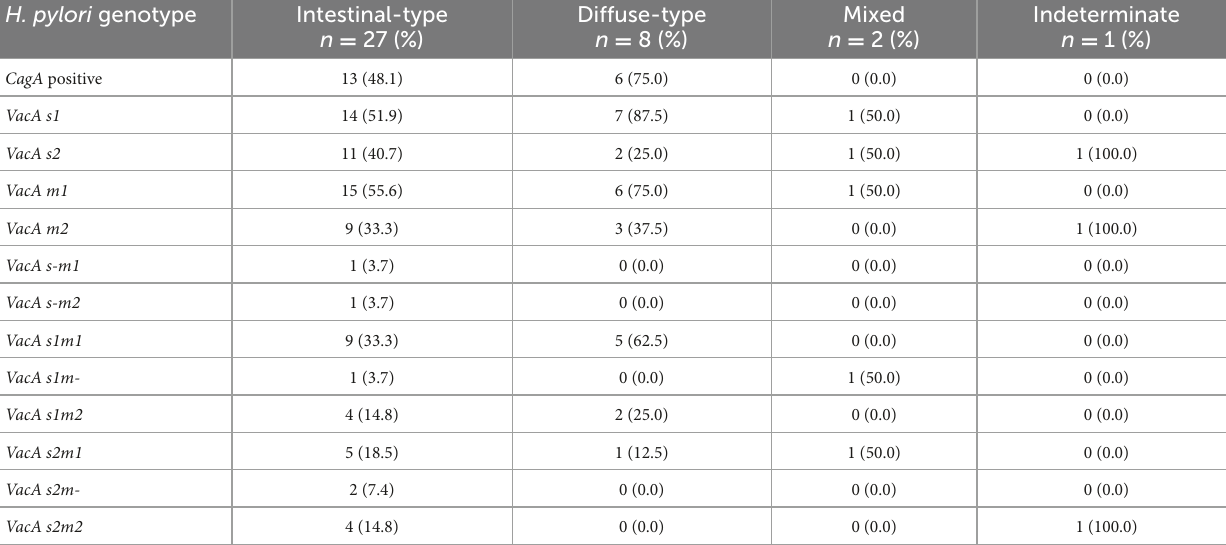
TABLE 2 Helicobacter pylori genotype distribution amongst the histologic subtypes of gastric